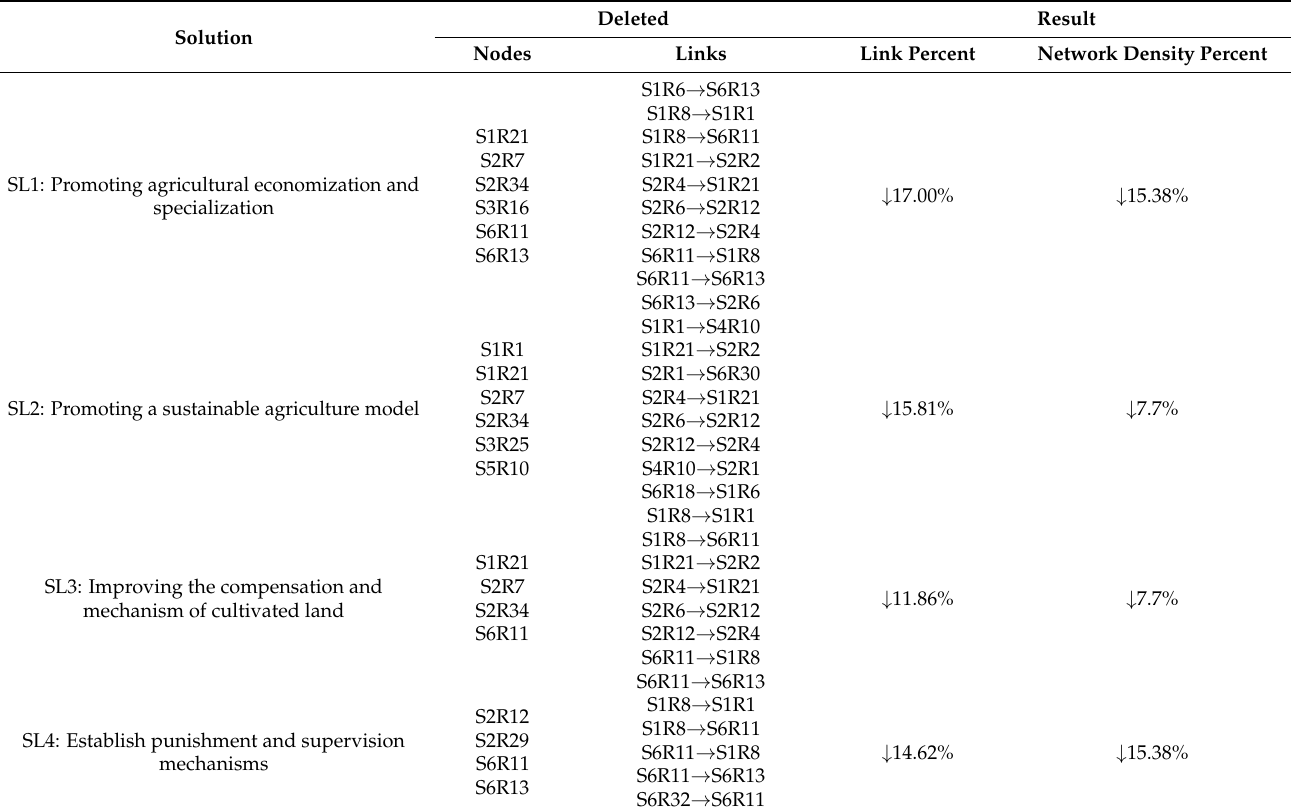
Figure 6. Risk network after mitigating critical risks and interaction. Note: S1, village committee; S2, local government; S3, land-use organization; S4, land non-flow farmers; S5, land flow-in farmers; S6, land flow-out farmers; and S7, the public. Table 5. Effectiveness verification of individual